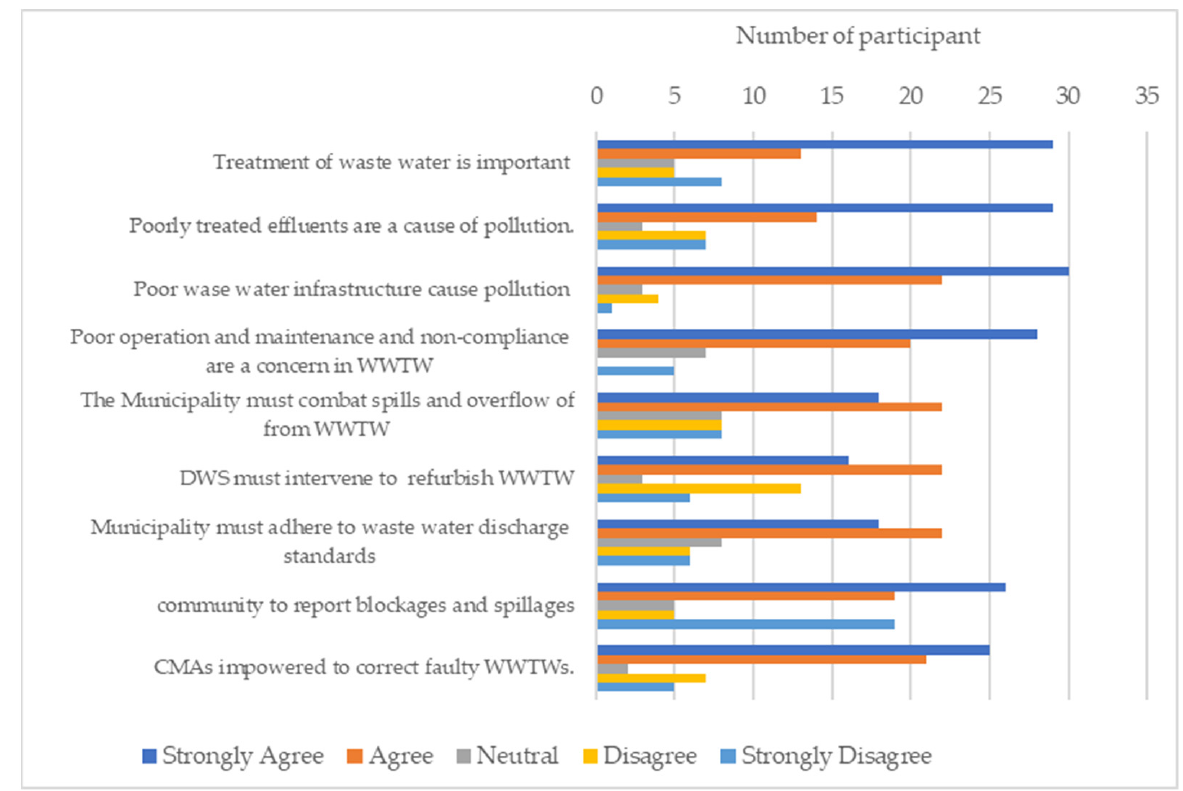
Figure 4. Factors from the WWTW that may contribute to the pollution of the Sand River Catch- ment.